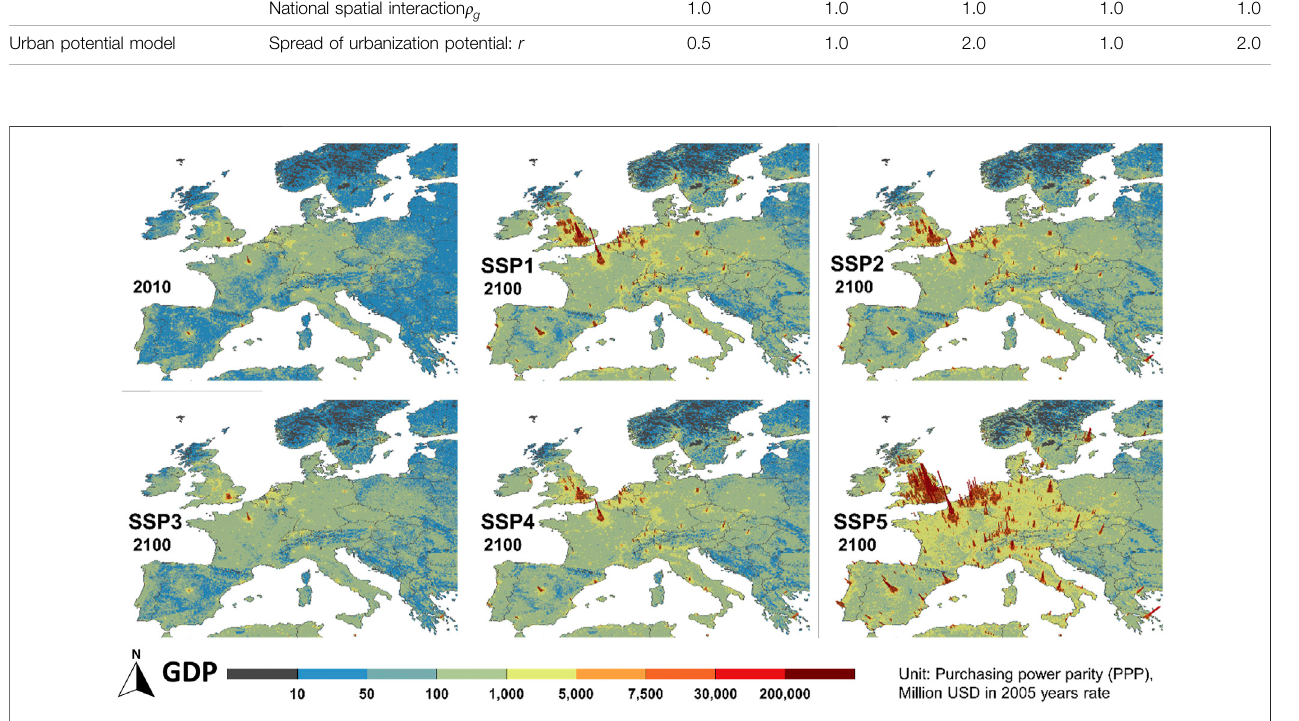
FIGURE 2 | Downscaled gross productivities in 2010 and those in 2,100 the SSP 1 – 5 (Europe).